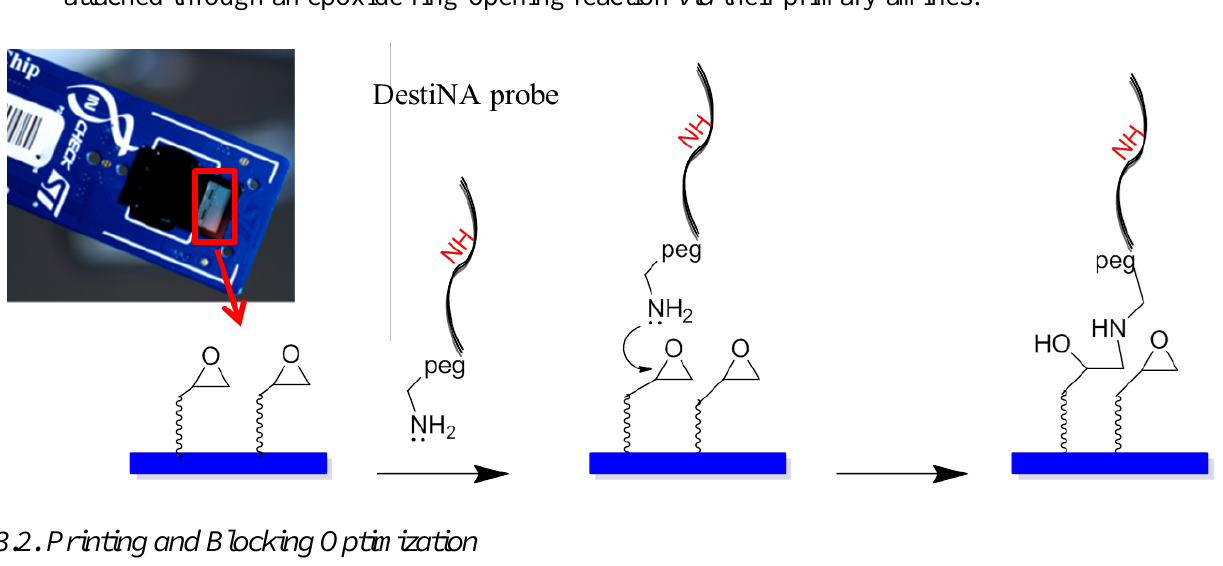
Figure 4. Modified DestiNA probes immobilization. DestiNA probes were covalently attached through an epoxide ring-opening reaction via their primary